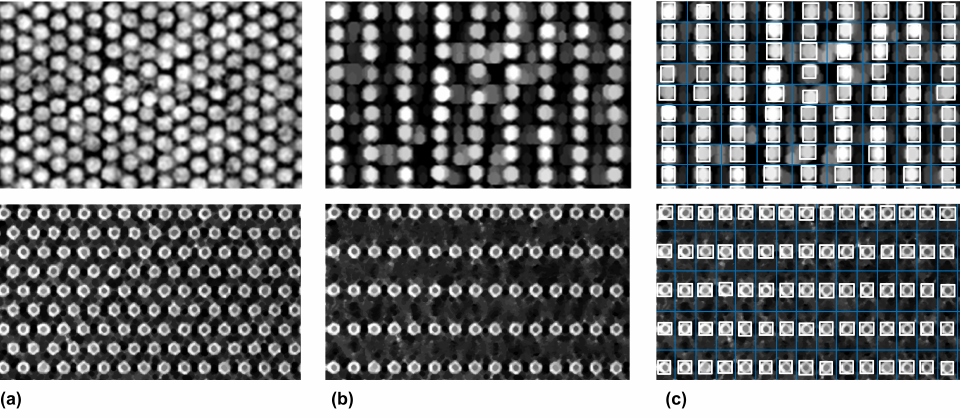
Figure 4. ( a ) Preprocessed images registered from hexagonal-array structure of pixelated CsI(Tl) scin- tillation screens ( top ) and hexagonal nanodisk–nanohole hybrid structure arrays ( bottom ). ( b ) Dual image decomposition based on shock filters driven by mathematical morphology; ( c )